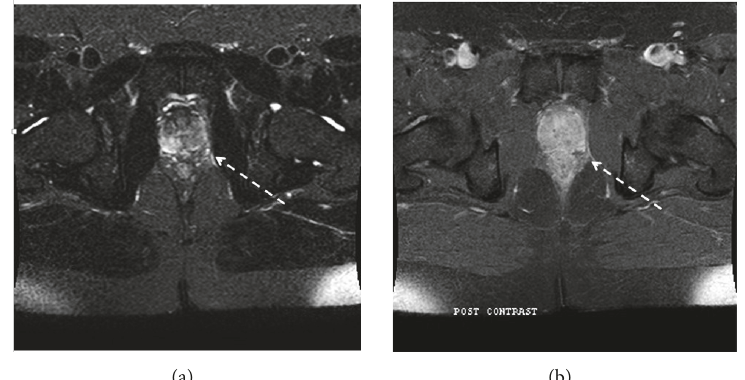
Figure 4: MRI of pelvis: axial FS T2WI (a), axial postcontrast T1WI (b). After aspiration and antibiotic therapy showing resolution of the previous intraprostatic